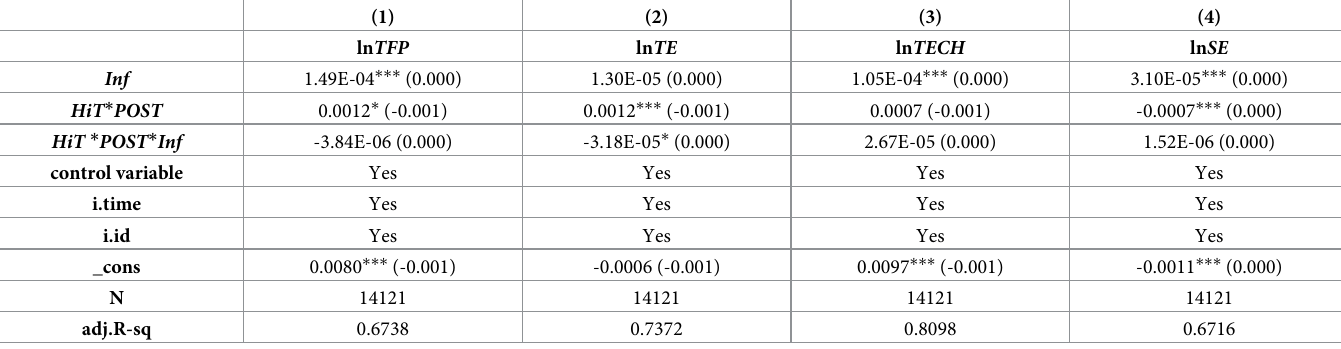
Table 5. Results of the indirect effect of IA on the efficiency of "True" digital enterprises.